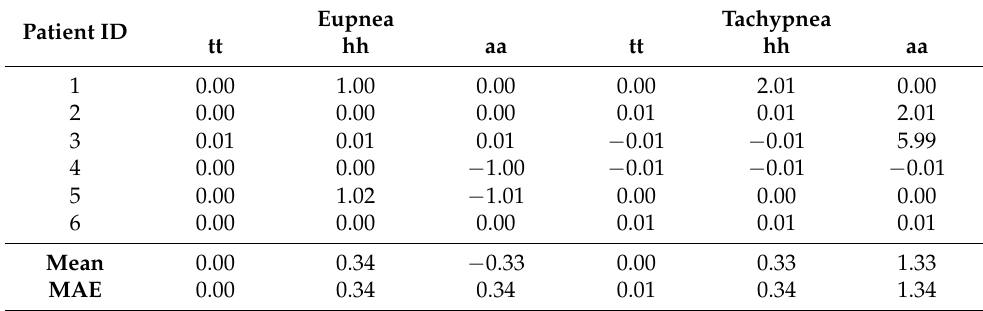
Table 2. Err and MAE for the tt, hh, and aa